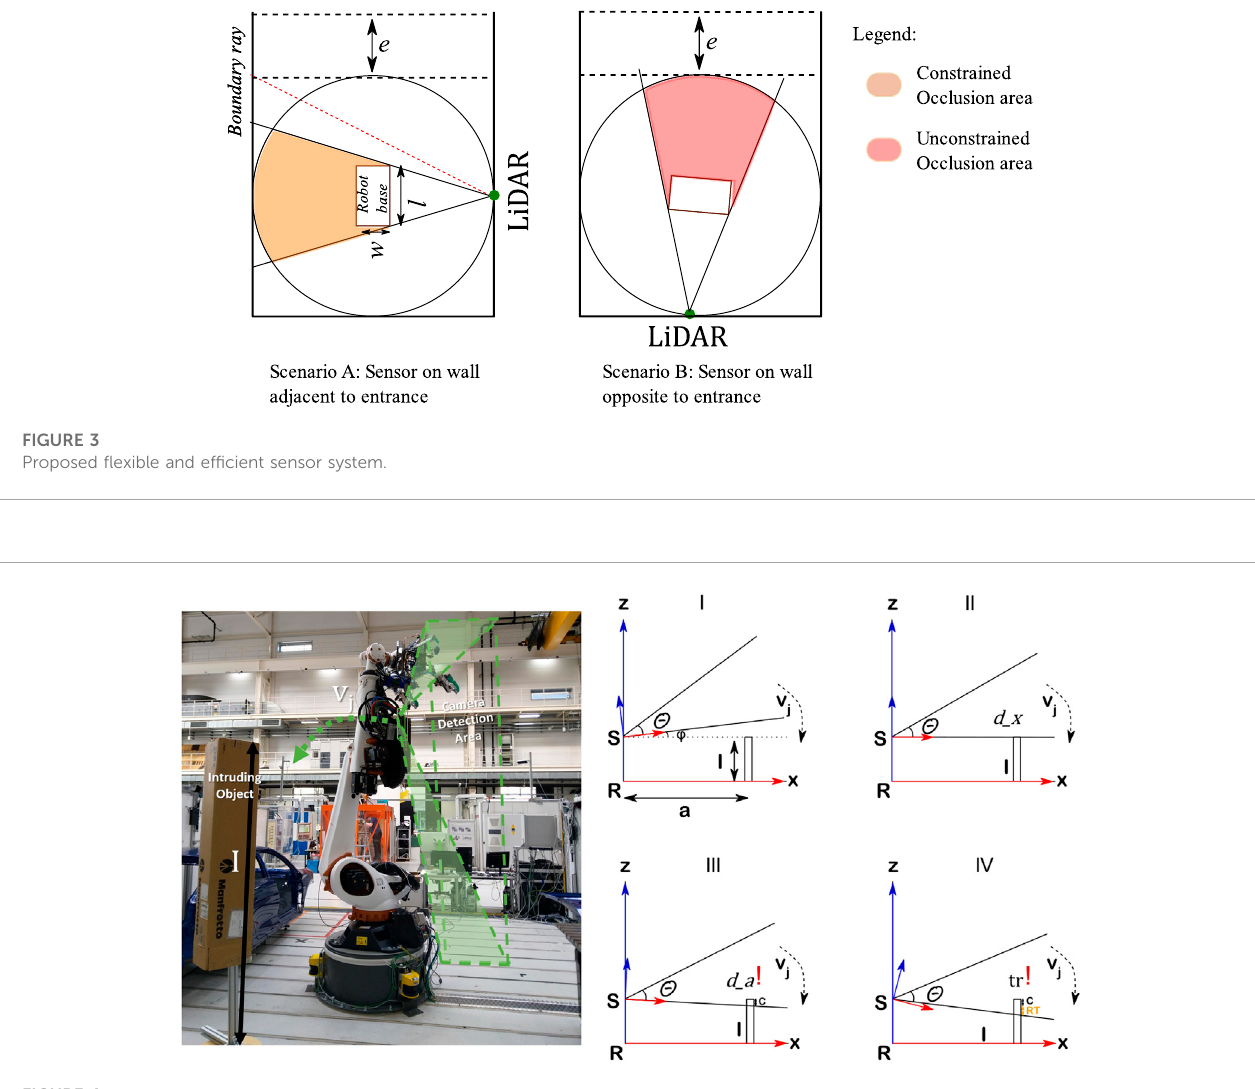
FIGURE 4 LiDAR sensor